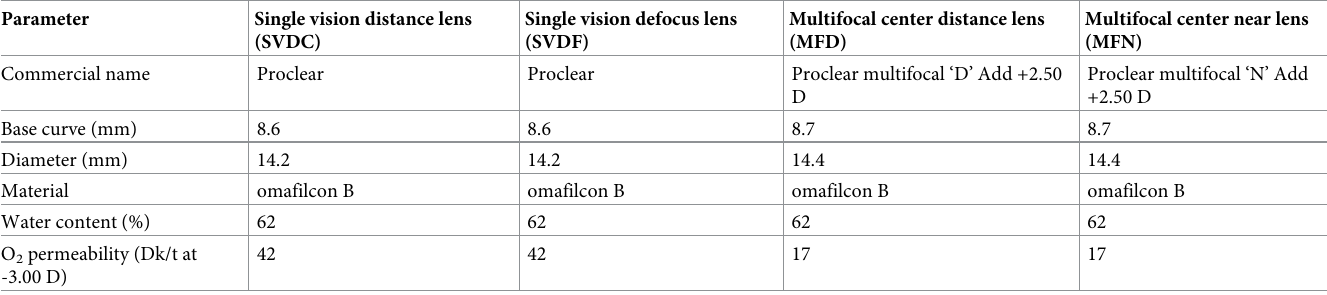
Table 1. Applied contact lenses with parameters.